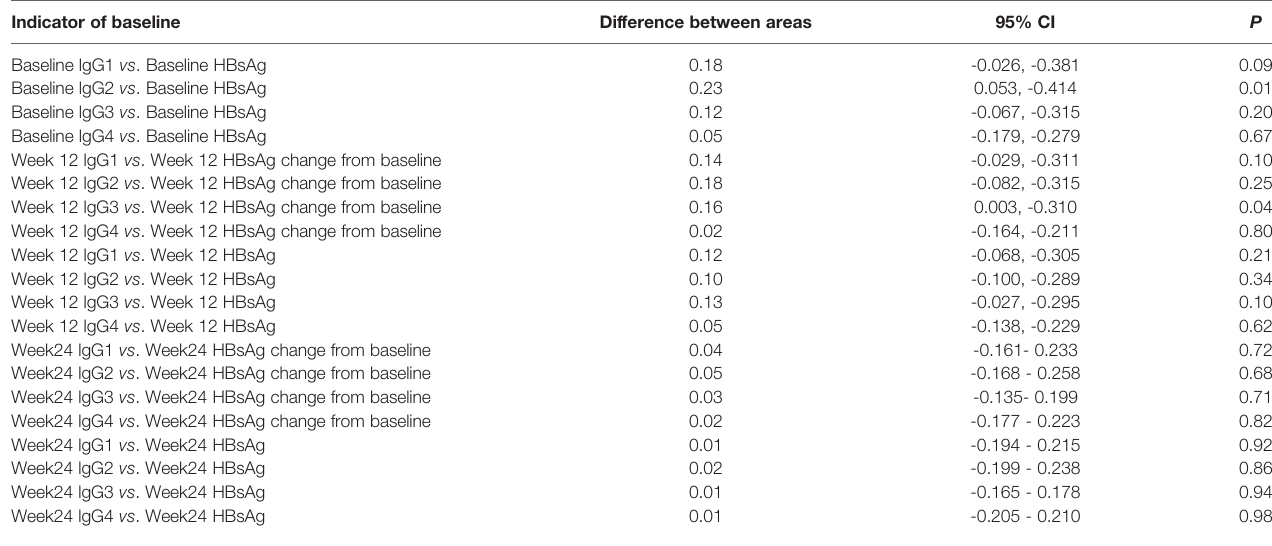
TABLE 3 | Comparison of the areas under the ROC curves for each indicator at baseline and 12 weeks, 24 weeks. Indicator of baseline Difference between areas Baseline lgG1 vs . Baseline